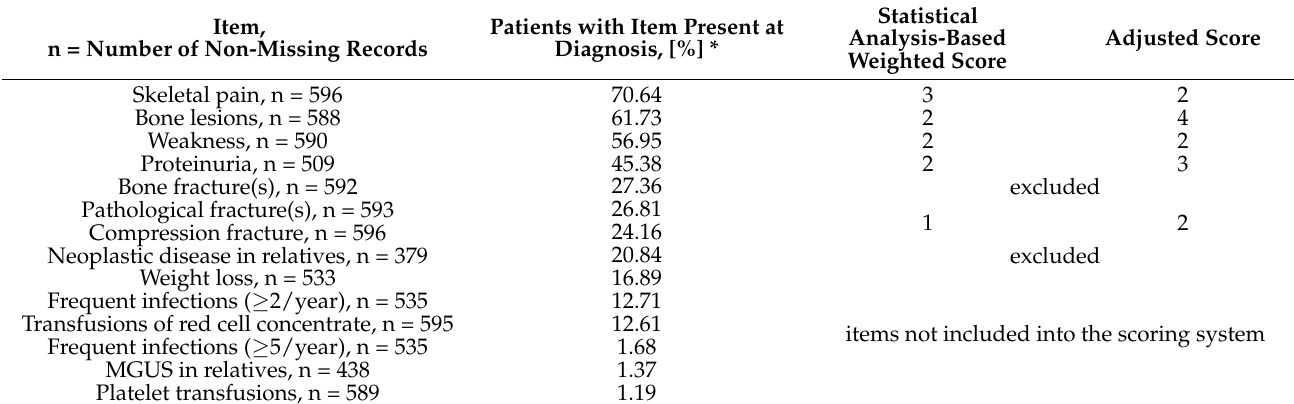
Table 2. Frequencies of outcomes observed in the studied population (N = 605). Based on the analysis of outcomes each item was weighted and in the second step weights were adjusted based on clinical knowledge and the literature review. They were used at step 1 of the screening based on interview with the